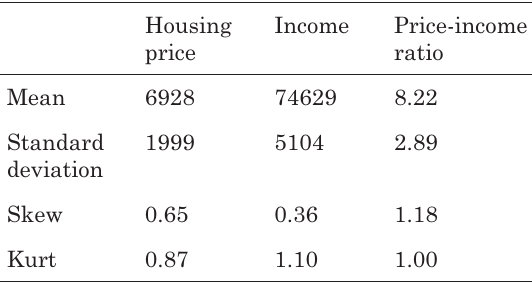
Table 1. Preliminary statistic